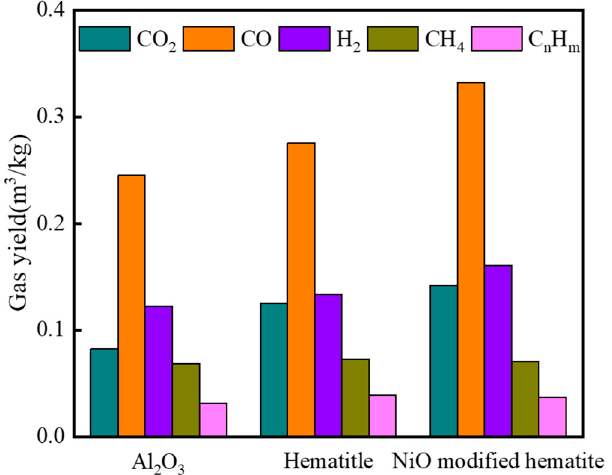
Figure 4. The effects of various OCs on wood waste gasification.